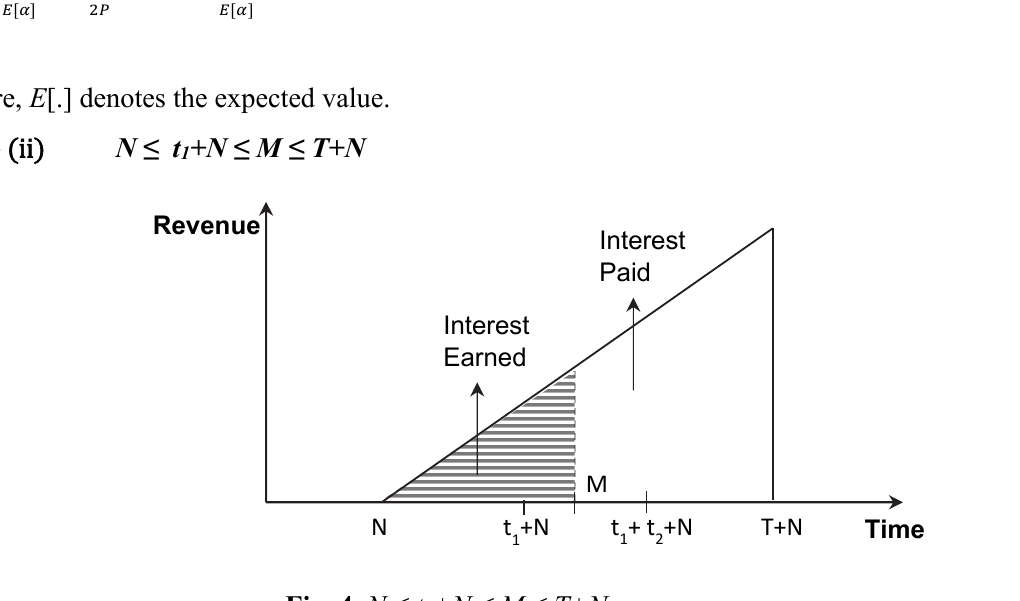
Fig. 4. N ≤ t 1 +N ≤ M ≤